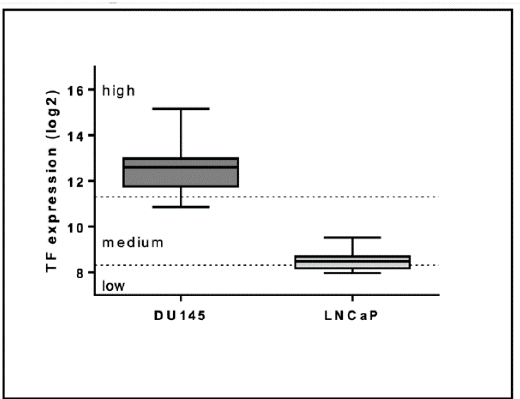
Figure 1. Tissue factor (TF) expression of DU145 and LNCaP cells was assessed with the Genevestigator platform ( https://genevestigator.com/) (accessed 23 March 2021 ). The whiskers represent minimum and maximum values, the boxes the 25–75% percentile, and the lines the median values ( n = 57 for DU145 and n = 26 for LNCaP). Low, medium, and high expression are defined as set by the Genevestigator platform.